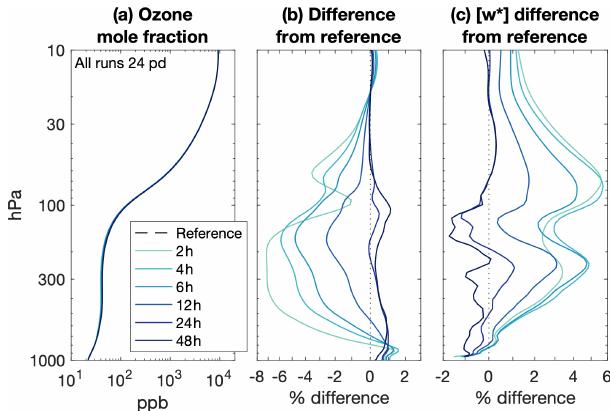
Figure 10. Tropical ozone (a) mean and (b) percent difference from the reference meteorology, and (c) residual vertical velocity for all nudging timescales at 24 meteorology updates per day. Average taken from 20 ◦ S to 20 ◦